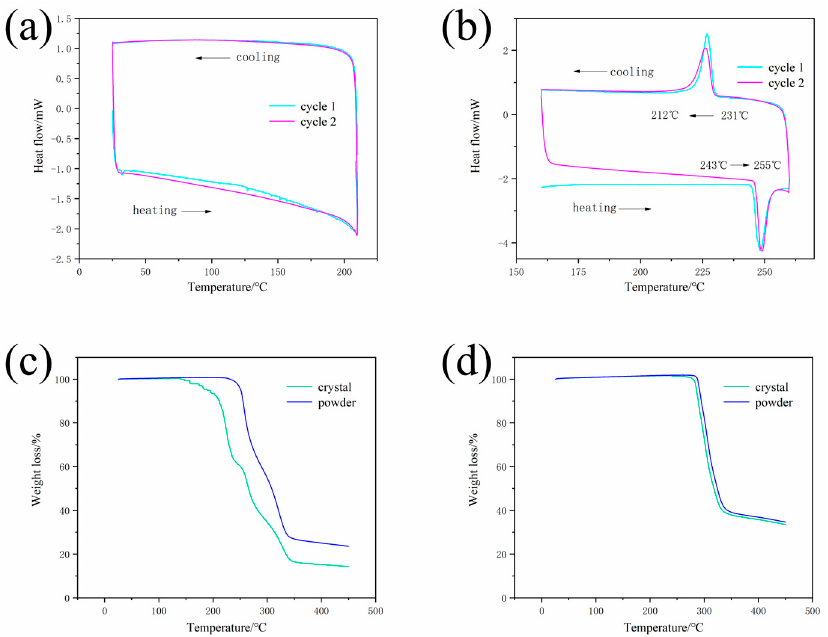
Figure 2. DSC curves of TMP-25HBA ( a ) and TMP-OA ( b ) on two heating–cooling cycles and TGA (Thermogravimetry Analysis) curves of TMP-25HBA ( c ) and TMP-OA ( d ). The heating and cooling rates are 5 °C/min.